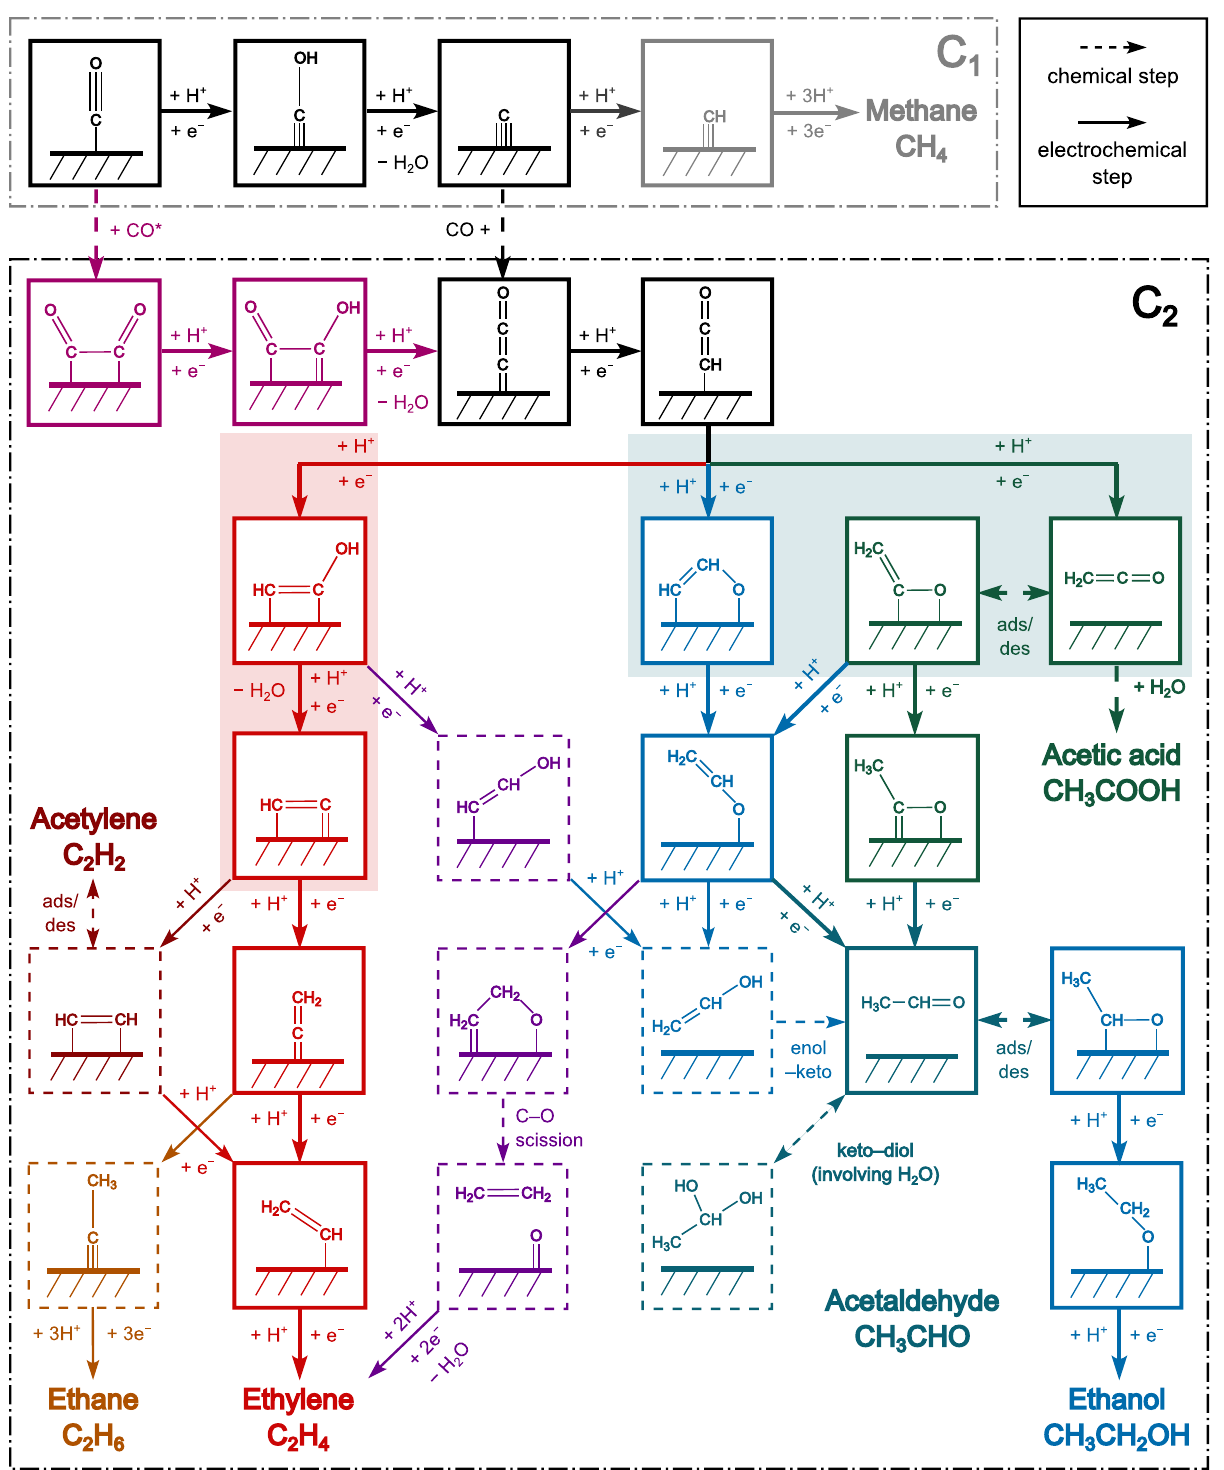
Fig. 1 Schematic diagram of reaction steps beyond CO. Reaction intermediates involved in major pathways are shown in solid squares with different colors: (1) Common pathways via COH*/C* towards both C 1 and C 2 products (black/grey) and additional C 2 pathway via OCCO*/OCCOH* (magenta). The above pathways control the total COR rate. (2) Major selectivity-determining pathways trifurcating from CHCO*, including the CHCOH pathway towards ethylene as the main C 2 HC product (red), the OCHCH pathway towards acetaldehyde and ethanol (blue), and the CH 2 CO pathway towards all three major Oxy species, i.e., acetic acid/acetate, acetaldehyde, and ethanol (green). The important steps governing whether the last C – O bond is cleaved or preserved are marked with light red and light cyan backgrounds, respectively. (3) Minor pathways branching off the major pathways are indicated by dashed squares, including the CHCOH pathway towards minor C 2 HC products (brown for acetylene and gold for ethane), the CHCOH pathway towards C 2 Oxys (purple, via CHCHOH*), and the OCHCH/CH 2 CO pathways towards ethylene (purple, via OCH 2 CH 2 *). Solid arrows refer to electrochemical protonation steps and dashed arrows refer to chemical processes.